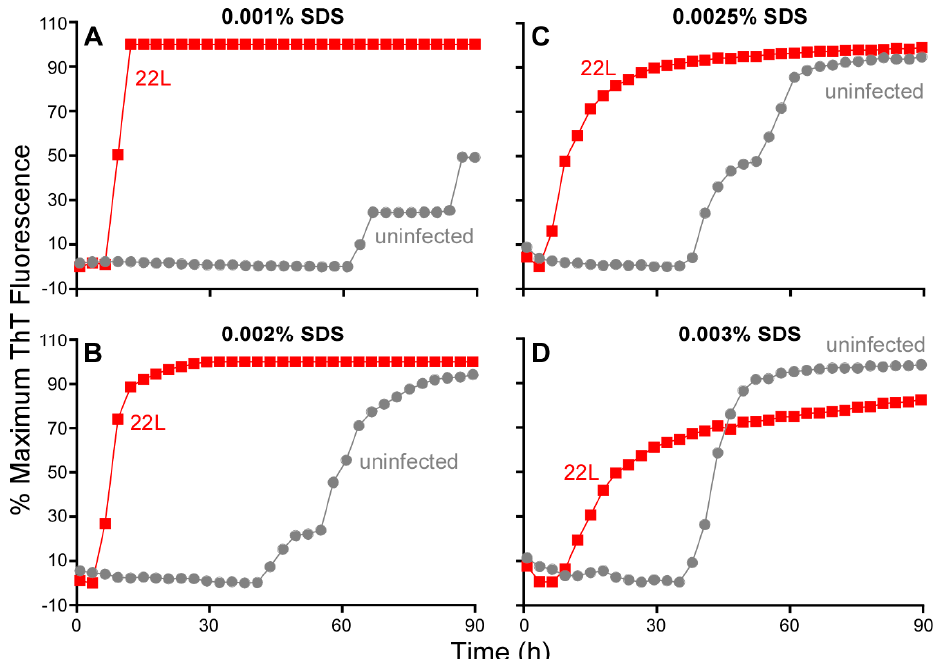
Figure 8. Effect of SDS on prion seeded and unseeded RT-QuIC reactions. Brain homogenate from 22L prion strain infected (red) and uninfected (gray) mouse were serially diluted in 0.1% SDS/PBS/N2 solution. The final dilution (1 × 10 − 4 brain tissue dilution) used to seed each well was prepared to give a final SDS concentration per reaction of: 0.001% ( A ); 0.002% ( B ); 0.0025% ( C ); or 0.003% ( D ). Mouse rPrP Sen (23–231) was used as the substrate in combination with 130 mM NaCl and all conditions were run in a single reaction plate. The average normalized fluorescence ( y -axis) from replicate wells is plotted as a function of time ( x -axis, h). Although ThT readings were taken every 45 min, for visual clarity, the curves report only readings at 135-min intervals.